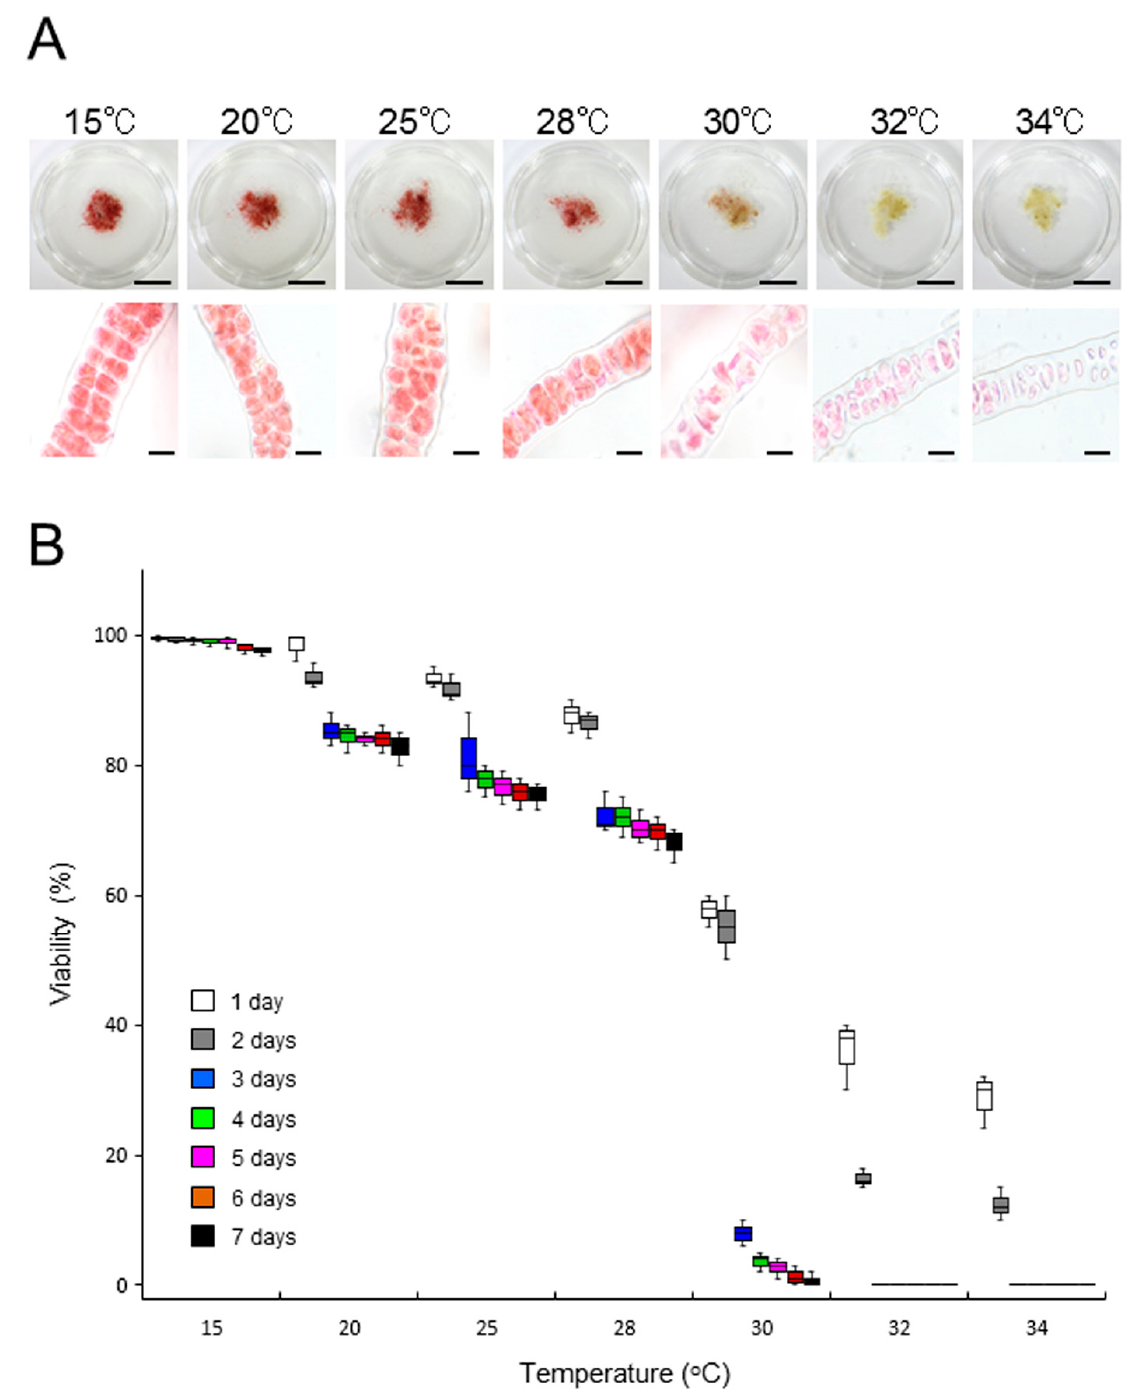
Figure 4. Effects of temperature on the viability of Bangia atropurpurea thalli. Samples of the laboratory-maintained culture (0.05 g) were incubated at 15, 20, 25, 28, 30, 32, and 34 °C for 7 days, and changes in body color and viability of cells were observed: ( A ) Comparison of body color (upper panels) and staining pattern with erythrosine (lower panels) among thalli treated with various temperature for 7 days. Scale bars, 1 cm in the upper panels and 25 μ m in the lower panels; ( B ) Quantification of viability. Viability of thalli incubated at various temperatures was examined daily by staining with 0.01% erythrosine. Error bars indicate the standard deviation of triplicate experiments ( N = 3).